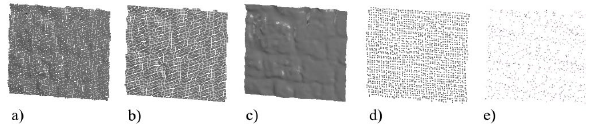
Figure 7. Surface density analysis (1mq). a) Lidar data;